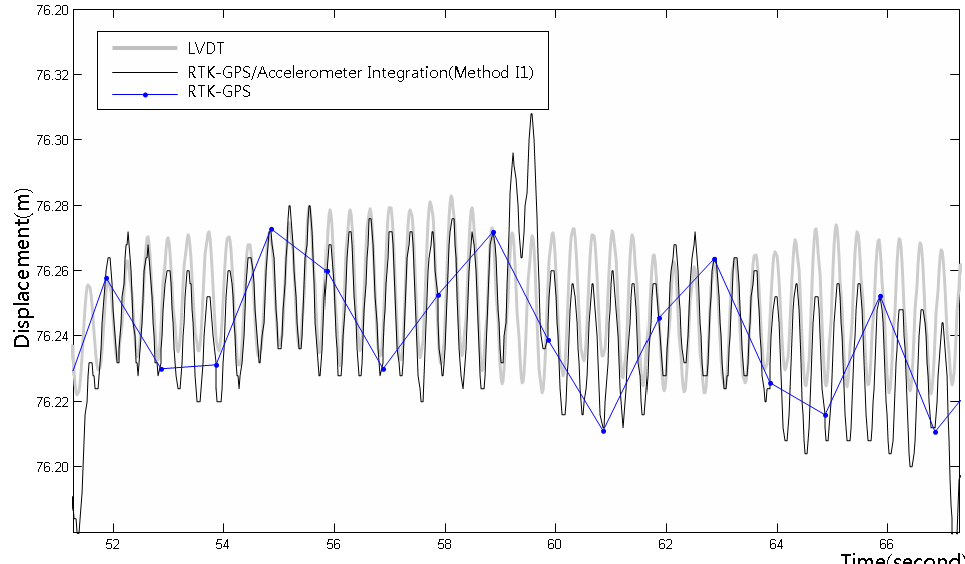
Figure 15. LVDT measurements and integrated RTK-GPS/accelerometer calculation results for the enlarged dashed rectangle area in Figure